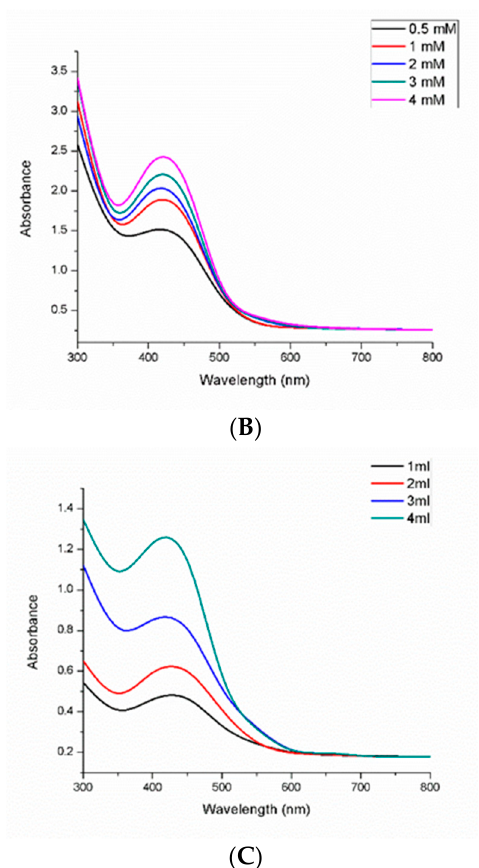
Figure 2. The UV-Visible spectrum of synthesized parthenium silver nanoparticles (PrSNPs) ( A ) as a function of time ( B ) as a function of silver nitrate concentration ( C ) and as a function of leaf extract concentration.